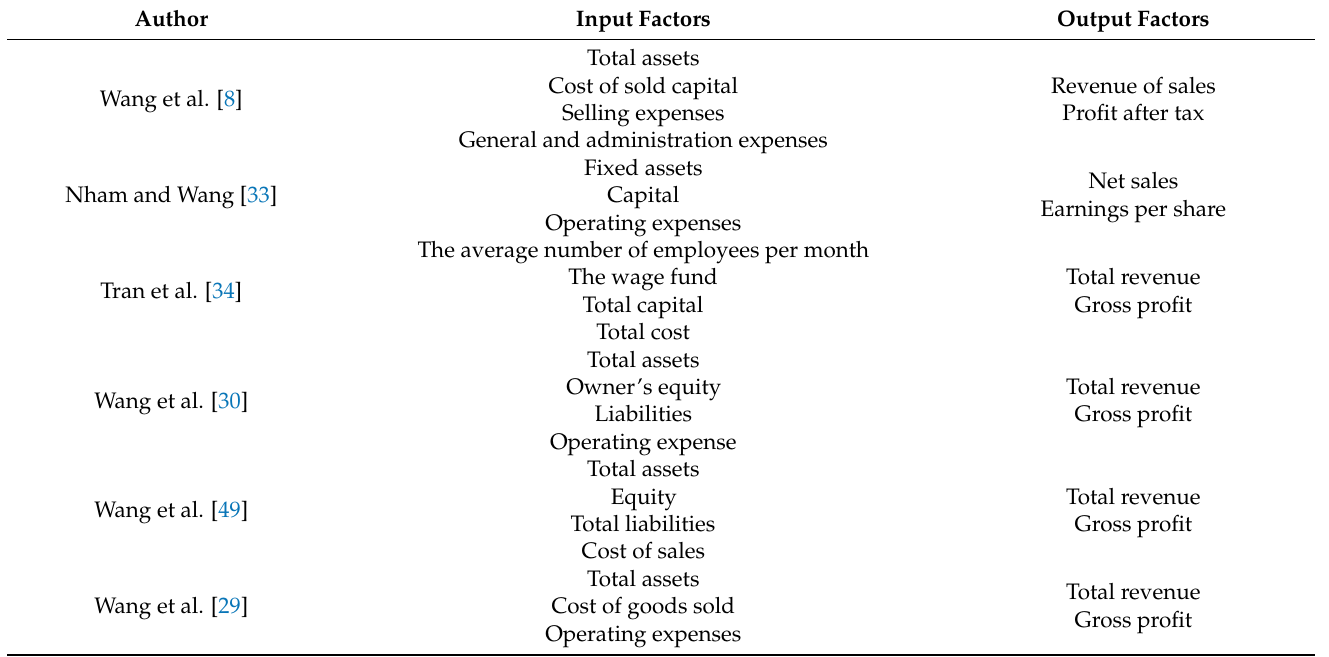
Table 3. Input and output variables used in related research.